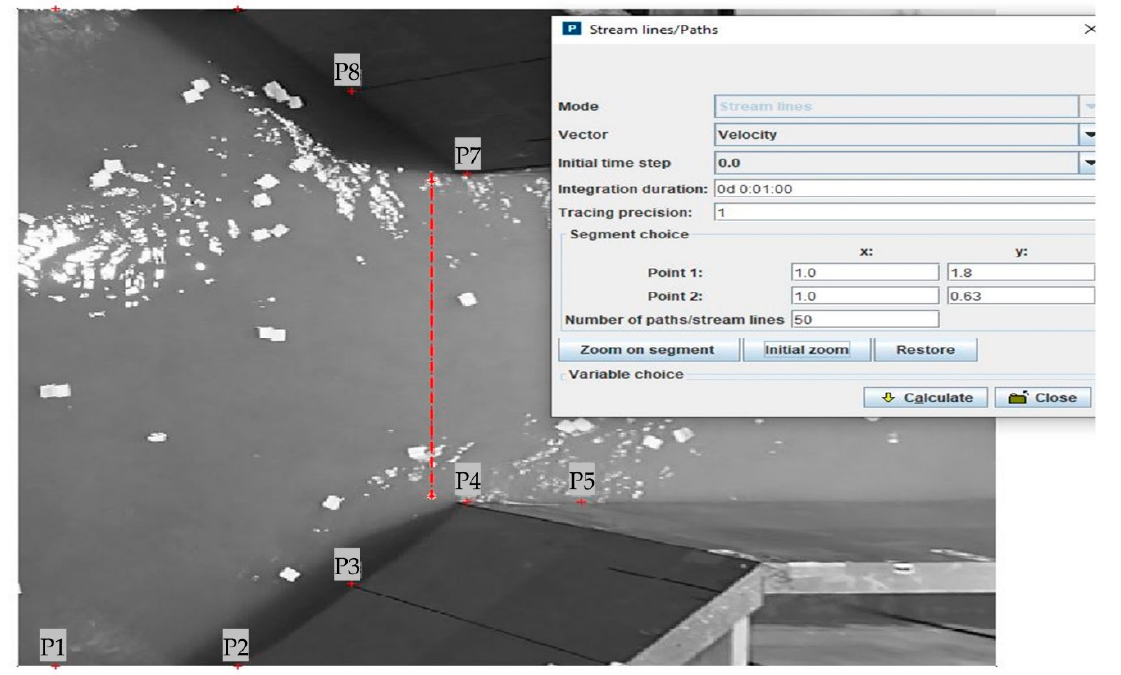
Figure 16. The defined transverse line is used for calculating the streamlines.